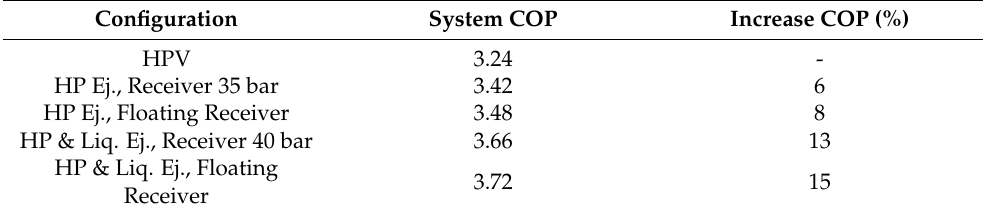
Table 4. Summary table of the average system COPs for the different configurations of CO 2 inte- grated refrigeration system and increase in COP (%) compared with the ejector-less (HPV) system layout.